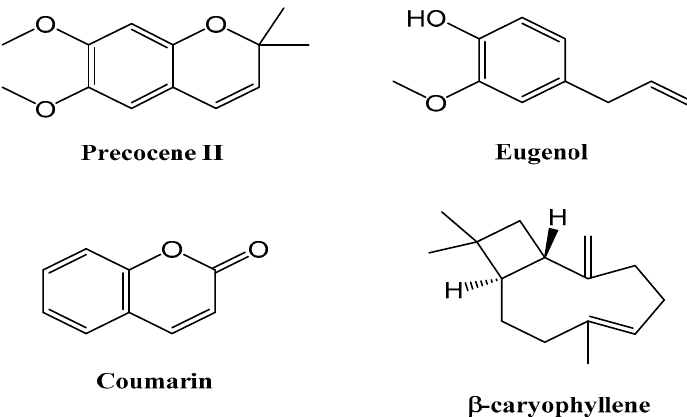
Figure 2. Chemical constituents of Ageratum conyzoides with antifungal activity. Table 2. Antifungal activities by main constituents extracted from Ageratum conyzoides.